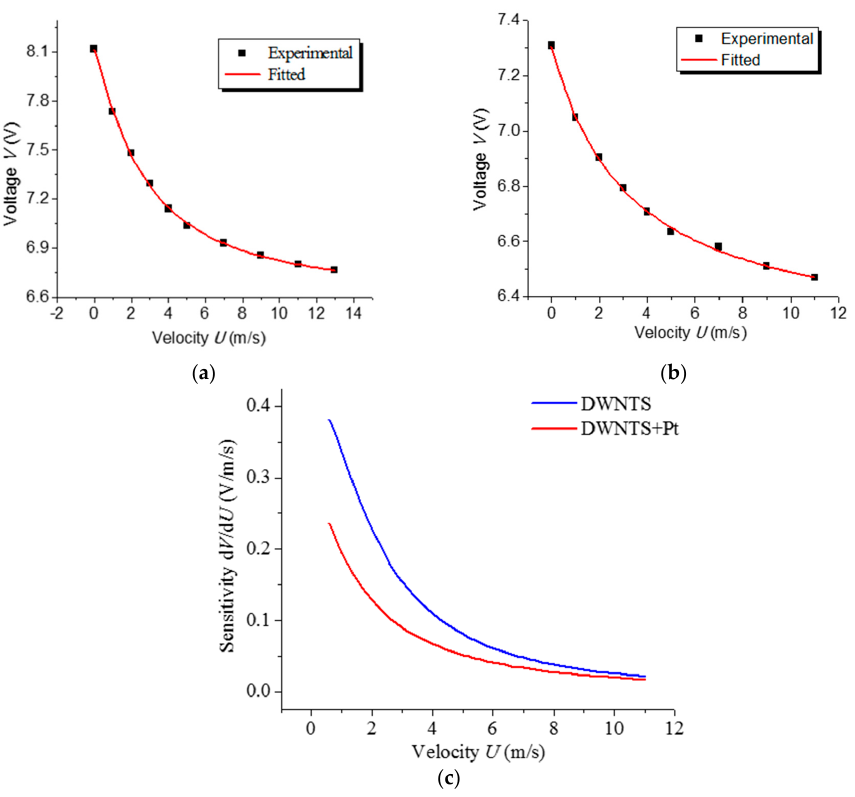
Figure 3. Output voltages and fittings by Formula (4) of an anemometer under diversified air velocity. ( a ) DWCNT hot wire, fitted exponent n = 1.21; ( b ) DCWNTs hot wire deposited by 10 nm Pt, fitted exponent n = 1.01; ( c ) Sensitivity of DCWNTs and Pt-coated DWCNT hot-wire in CC mode.